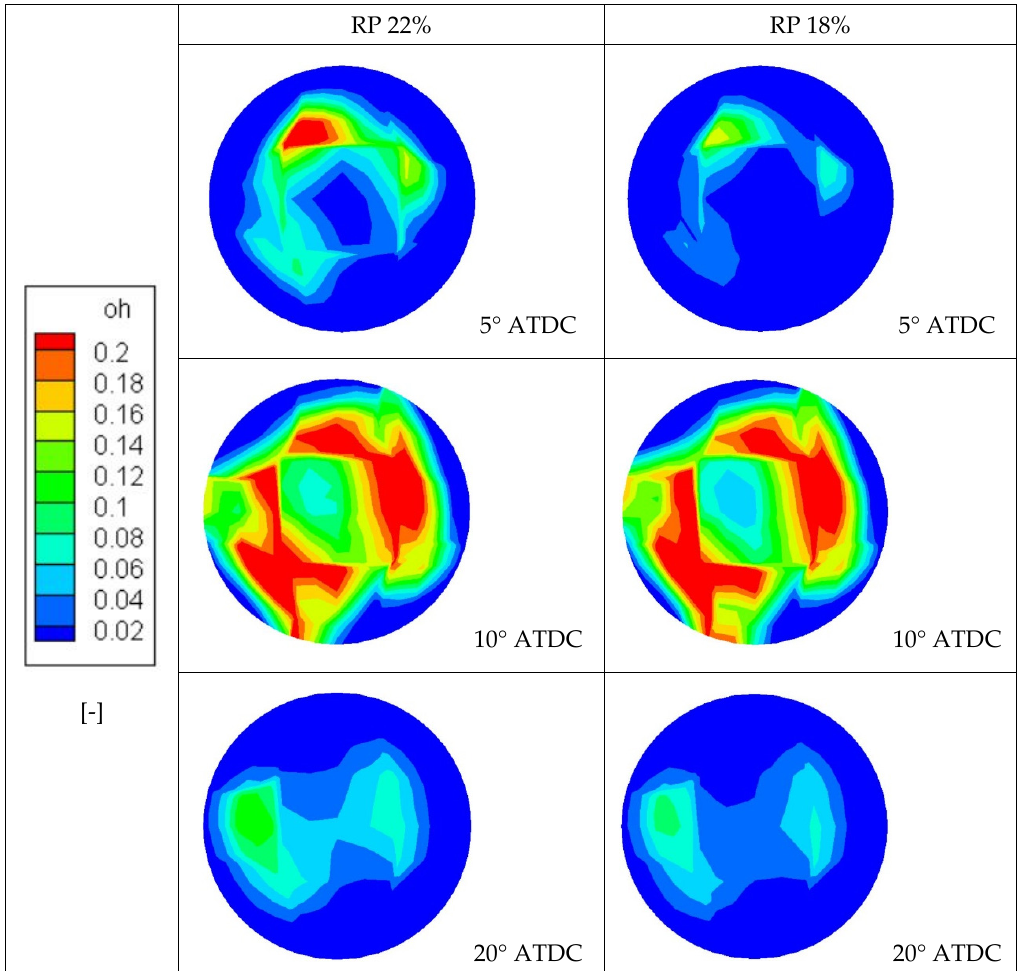
Figure 21. OH mass fraction contours for RP = 22 and 18% at 2000 rpm in a transversal plane.